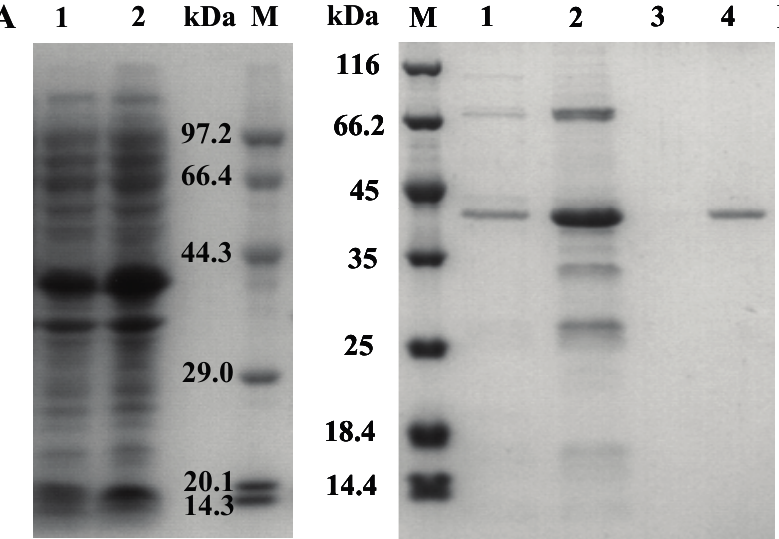
Figure 2. SDS-PAGE gel electrophoresis to confirm the expression ( A ) and purification ( B ) of recombinant protein AcCel12B. ( A ) 1, Supernatant of the cell lysate; 2, Pellet of the cell lysate; M, Protein marker; ( B ) M, Protein marker; 1–3, elutions in 50, 80, and 150 mM imidazole, respectively; 4, AcCel12B purified by Q-Sepharose ® Fast Flow